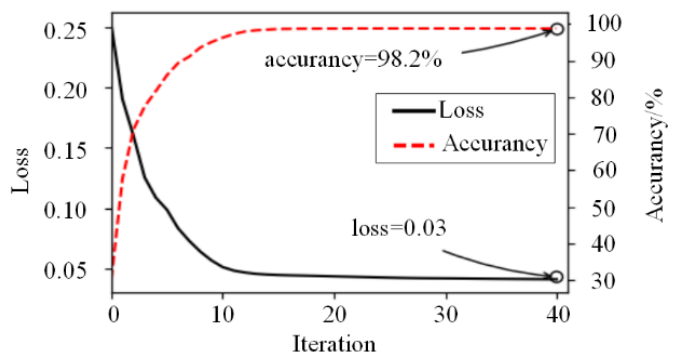
Figure 7. The change curve of DBN loss value and accuracy.